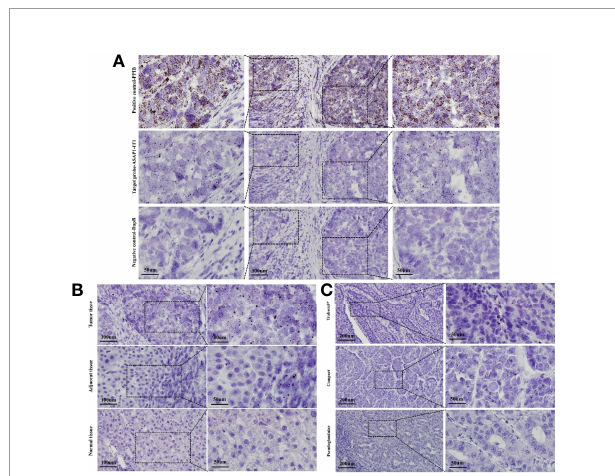
FIGURE 2 | RNAscope in situ hybridization for characterization of subcellular localization and expression of ASAP1-IT1 in hepatocellular carcinoma (HCC) tissues. (A) Subcellular localization of ASAP1-IT1 in the nucleus of hepatoma cells. The speci fi c probe for host gene PPIB was used as positive control, and non-speci fi c probe DapB was used as the negative control. (B) Abnormal high expression of ASAP1-IT1 in human HCC tissues. (C) ASAP1-IT1 expression levels in different liver cancer types. ASAP1-IT1 was highly expressed in trabecular type (n=27, 50.0%), lowly expressed in compact type (n=21, 38.9%), and nearly undetectable in pseudoglandular type of HCC (n=6,